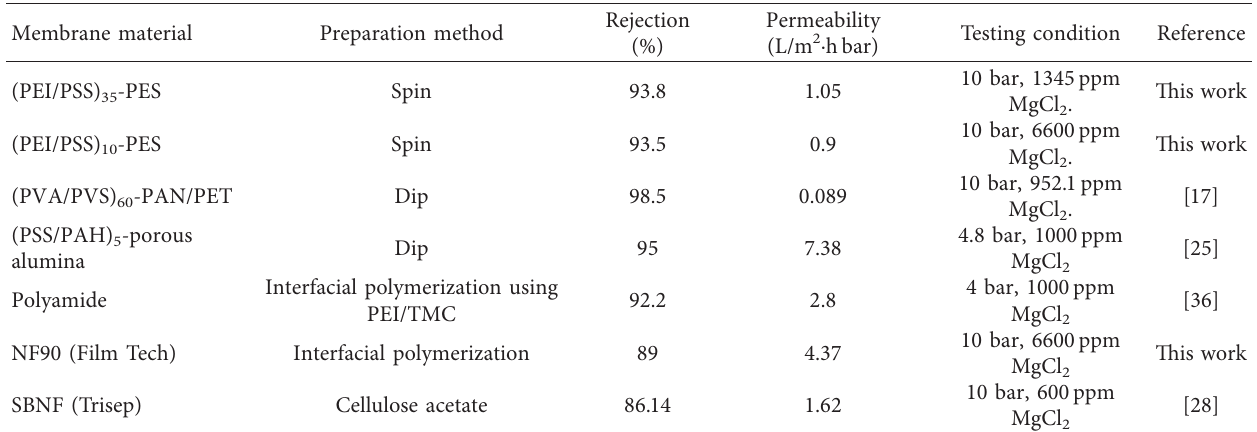
Figure 3: Effect of number of deposited PEI/PSS bilayers on salt rejection rate and permeability ( P � 10bar, T � 32.39 ± 0.27 ° C, Table 1: NF membrane performance